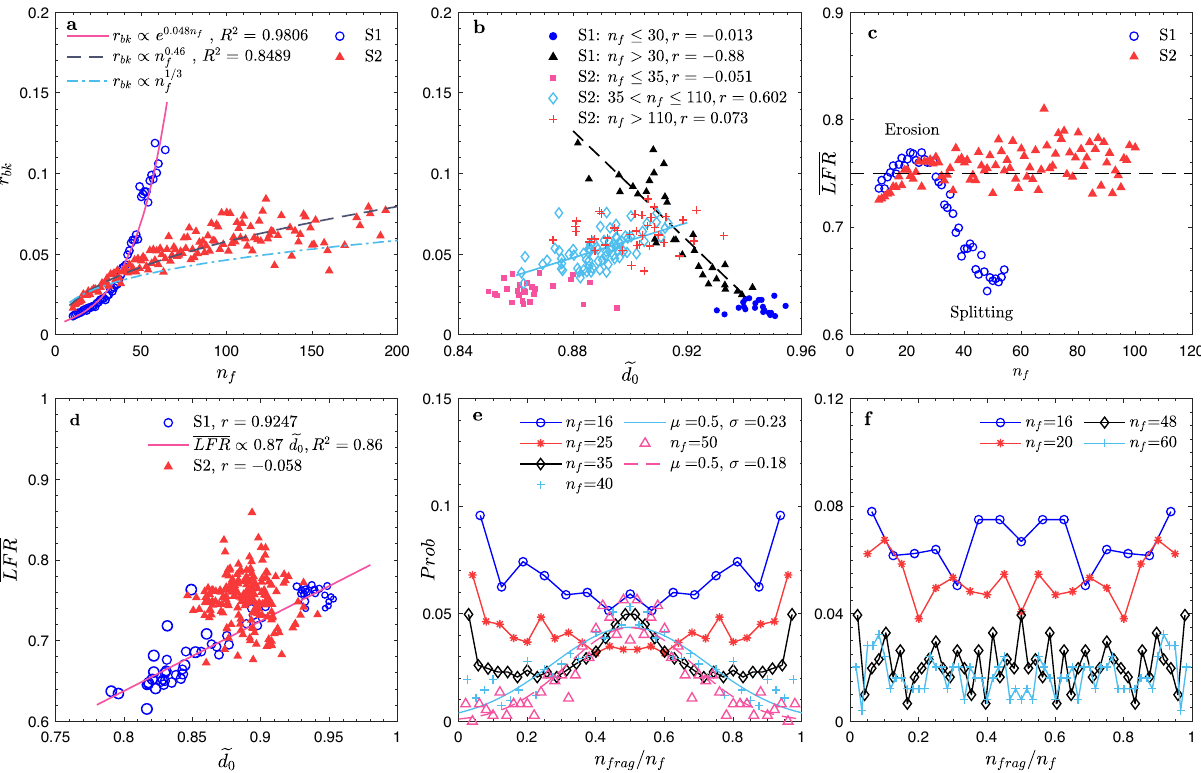
Figure 3. Effects of floc properties on the breakup process. Both floc size and floc structure can affect breakup, including the breakup rate and breakage distribution function. ( a ) Breakup rate r bk for flocs consisting of different number of primary particles in case S1 and S2. Power-law relation between n f and r bk is found for case V 1 / 3 S2, suggesting the independence of breakup rate on floc structure based on the empirical function r bk ∝ (which only considers the effect of floc size). r bk grows exponentially with n f , as larger flocs in S1 becomes increasingly fragile. ( b ) Breakup rate r bk changes with floc structure characterized by the normalized fractal d 0 . r is the correlation coefficient. r bk is negatively correlated with the floc fractal dimension in case dimension S1, while opposite relation is found in case S2, again showing the effect of structure on r bk for case S1 with lower Co . ( c ) The mean floc breakup mode for flocs of different sizes quantified by the largest fragment ratio LFR (cid:31) (Methods) averaged over flocs of given n f , denoted as LFR . Both cases show the dominance of erosion ( LFR >0.75) at specific size range. ( d ) Relations between the mean floc breakup mode ( LFR ) and the floc structure d 0 ), where larger marker size indicates larger floc size. Breakup mode is correlated with the floc structure in ( case S1, while it is independent of floc structure in case S2. ( e, f ) Breakage distribution function for S1 and S2. Fragment sizes are normalized by the corresponding size of the breaking floc, n frag / n f . Only data of flocs that (cid:31) 40 and 50 in case S1, the breakage distributions are fitted by a break into two fragments are included. For n f = normal distribution in ( e